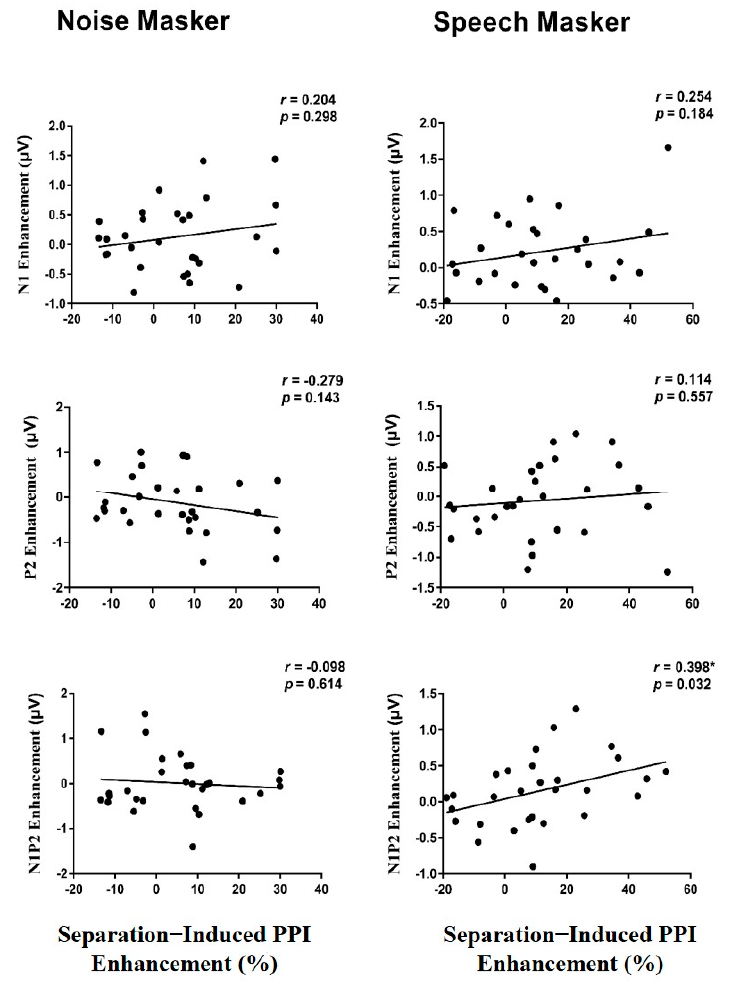
Figure 5. Correlations between the enhancement of the ERP amplitudes of the prepulse and the PPI enhancement under the two masking conditions. The enhancement of the N1P2 peak-to-peak component was significantly correlated with the PPI enhancement under the speech masking condition, but this was not the case for either the N1 enhancement or the P2 enhancement. Note the enhancement variable is the difference score between separation condition and co-location condition. * p < 0.05.